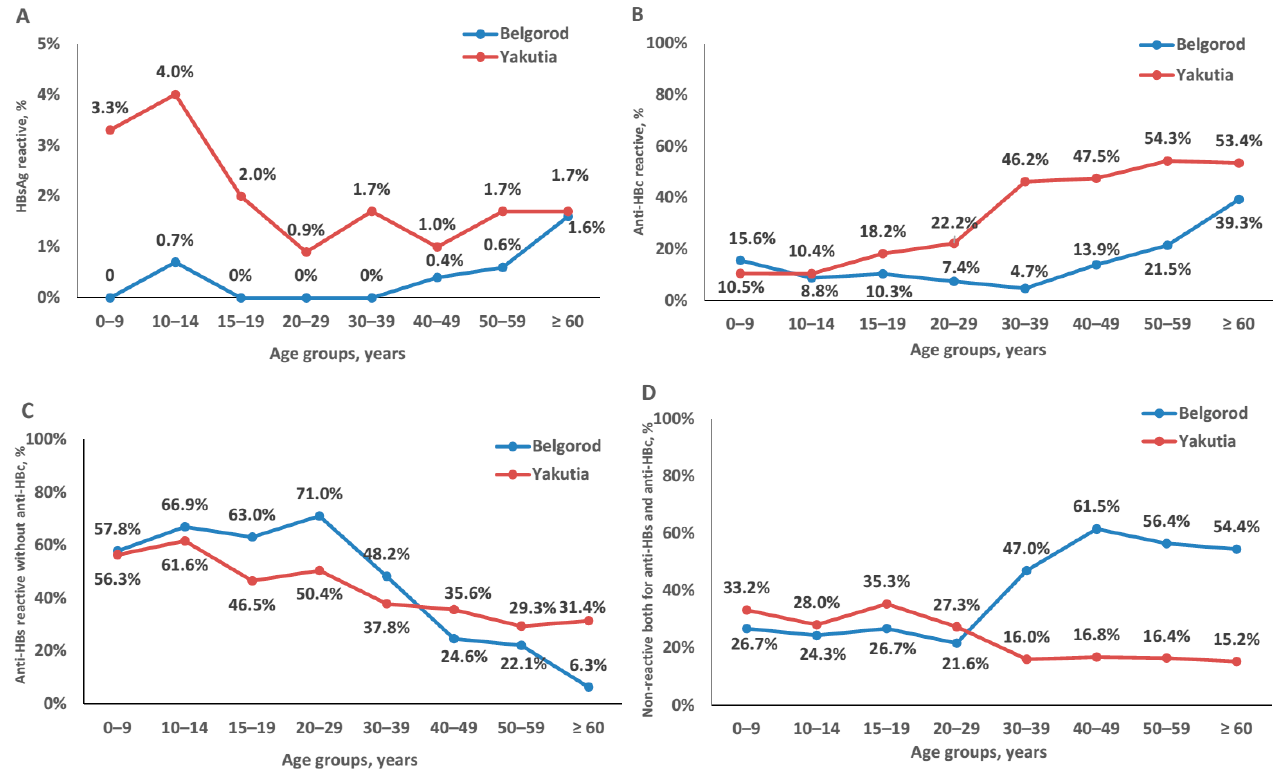
Figure 2. Proportions of serum samples reactive for hepatitis B markers in each age cohort of conditionally healthy individuals in the Belgorod Oblast and Yakutia: reactive for HBV surface antigen (HBsAg) ( A ); reactive for antibodies to HBV core antigen (anti-HBc) ( B ); reactive for antibodies to HBsAg (anti-HBs), but non-reactive for anti-HBc ( C ); non-reactive for either anti-HBs, or anti-HBc ( D ).